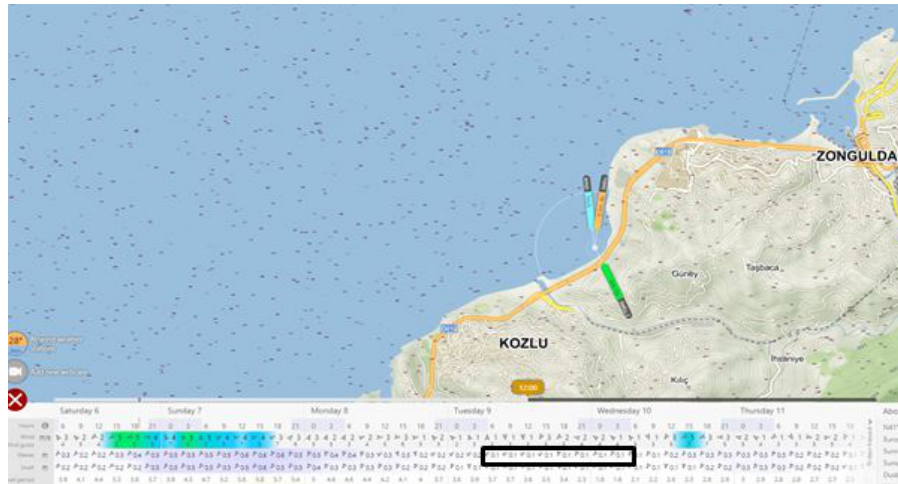
Figure 13. Wave prediction map dated 9 September 2020 for the